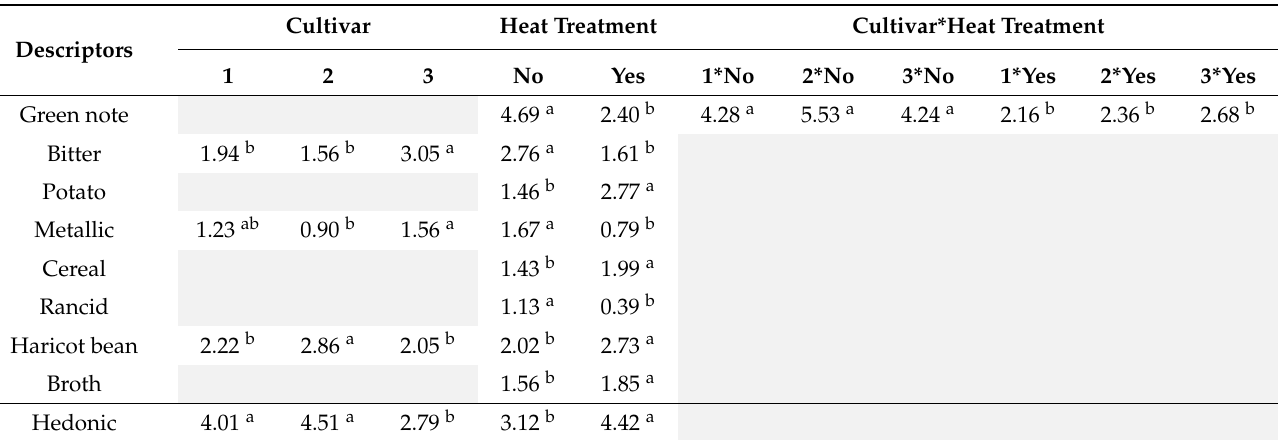
Table 6. Results of the Tukey HSD comparisons of 6 gels (C1, C2, C3, H1, H2 and H3; Table 1) for the descriptors with significant cultivar or heat treatment effects and/or cultivar*heat treatment interaction ( p -value < 0.05; Table 5). Significant differences between horizontal groups for each effect and interaction are indicated by differences in letters ( α = 0.05). Shade cells correspond to the absence of significant effect and/or interaction ( p -value > 0.05; Table